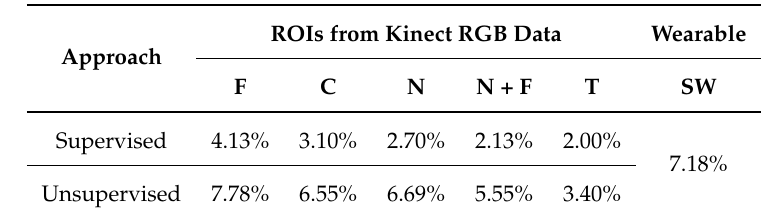
Table 2. Comparison among different methods (based on Kinect and wearable devices) for HR estimation, in terms of average error (%). The average HR over the 100 signals measured with the Holter is 77 bpm. N + F is the mean value of the sum of the N and F ROIs; T is the mean of the sum of all the ROI, identified as Total ROI; SW stands for